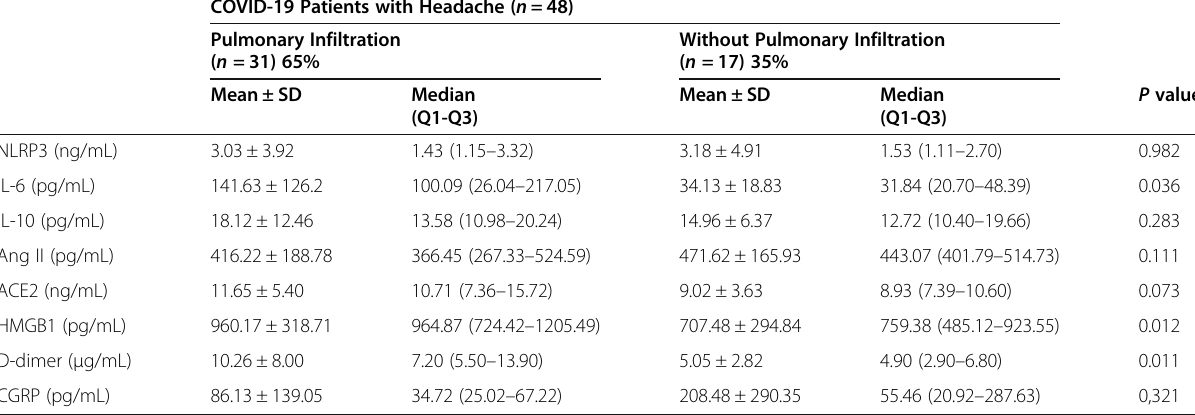
Table 2 Comparison of the inflammatory molecule levels in COVID-19 patients with headache regarding pulmonary involvement COVID-19 Patients with Headache ( n = 48) Pulmonary Infiltration ( n = 31)